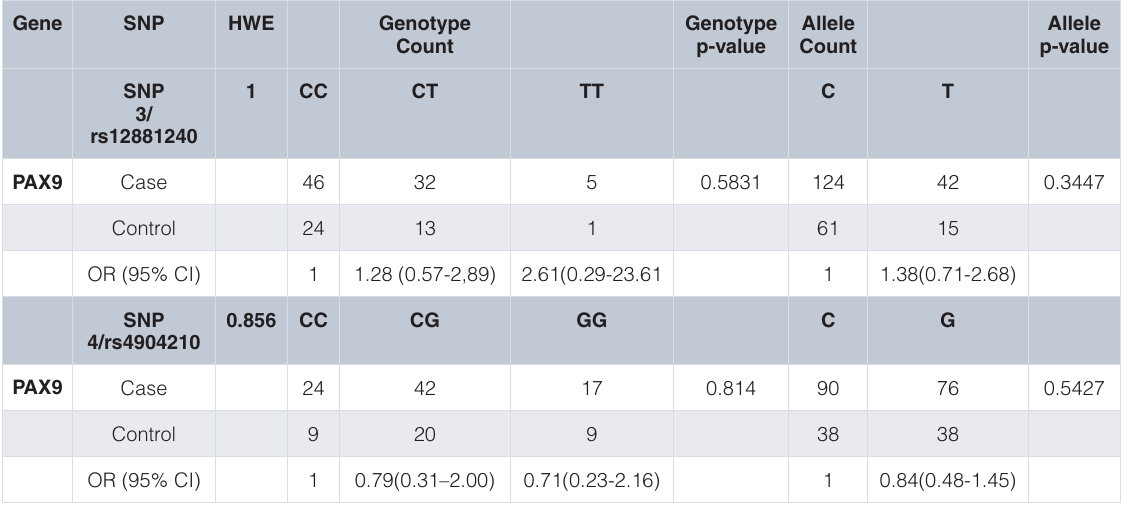
Table 8. Statistical analysis of associations between SNP and maxillary canine